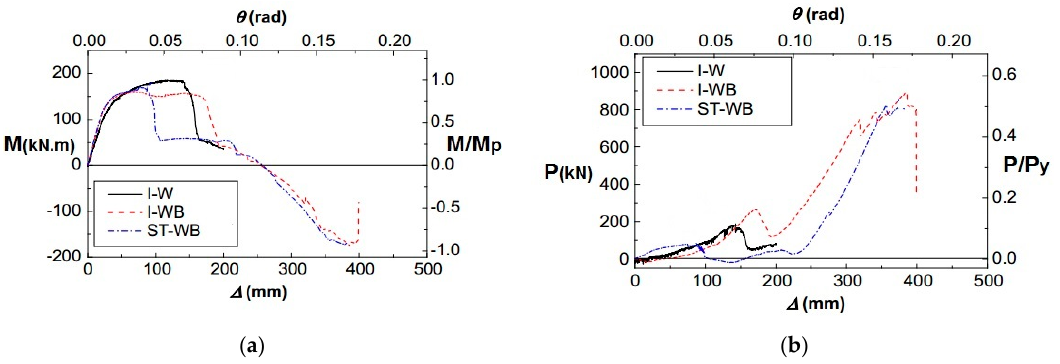
Figure 10. Load resistance mechanism: ( a ) development of a flexural mechanism 𝐹 (cid:3033) , and ( b ) development of a catenary mechanism 𝐹 (cid:3030)